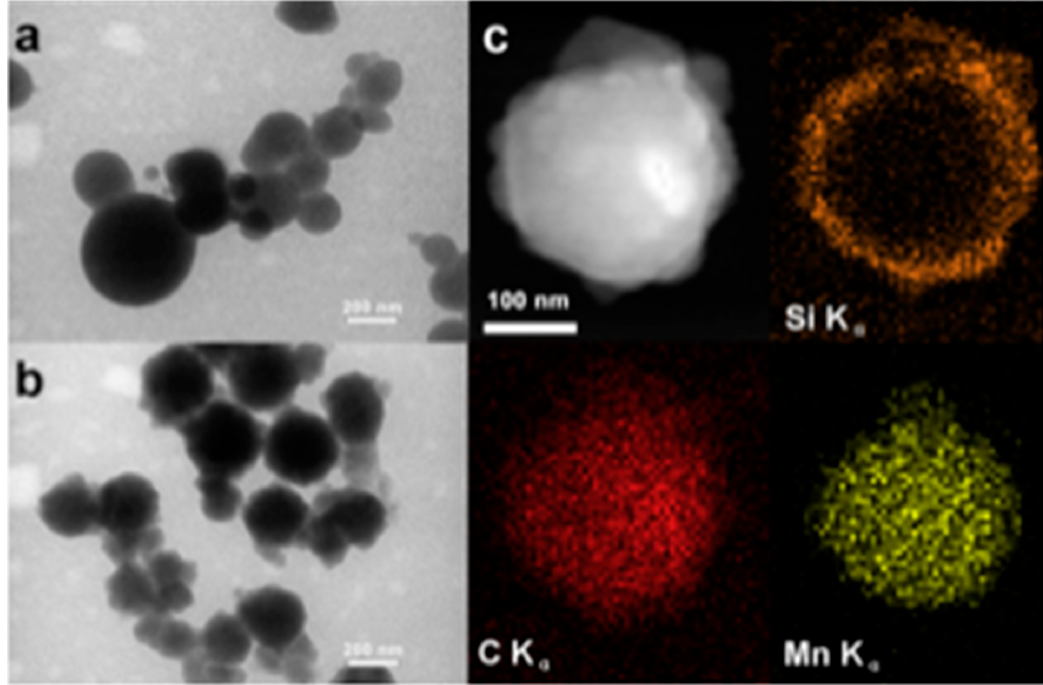
Figure 7. (a ) TEM image of PAA-Mn aggregate particles before silica coating, ( b ) TEM image of PAA-Mn aggregate particles after silica coating, ( c ) STEM image and Si, C, and Mn EDX mapping images of a single particle after silica coating. Reproduced from [116] with permission from Elsevier (2013).